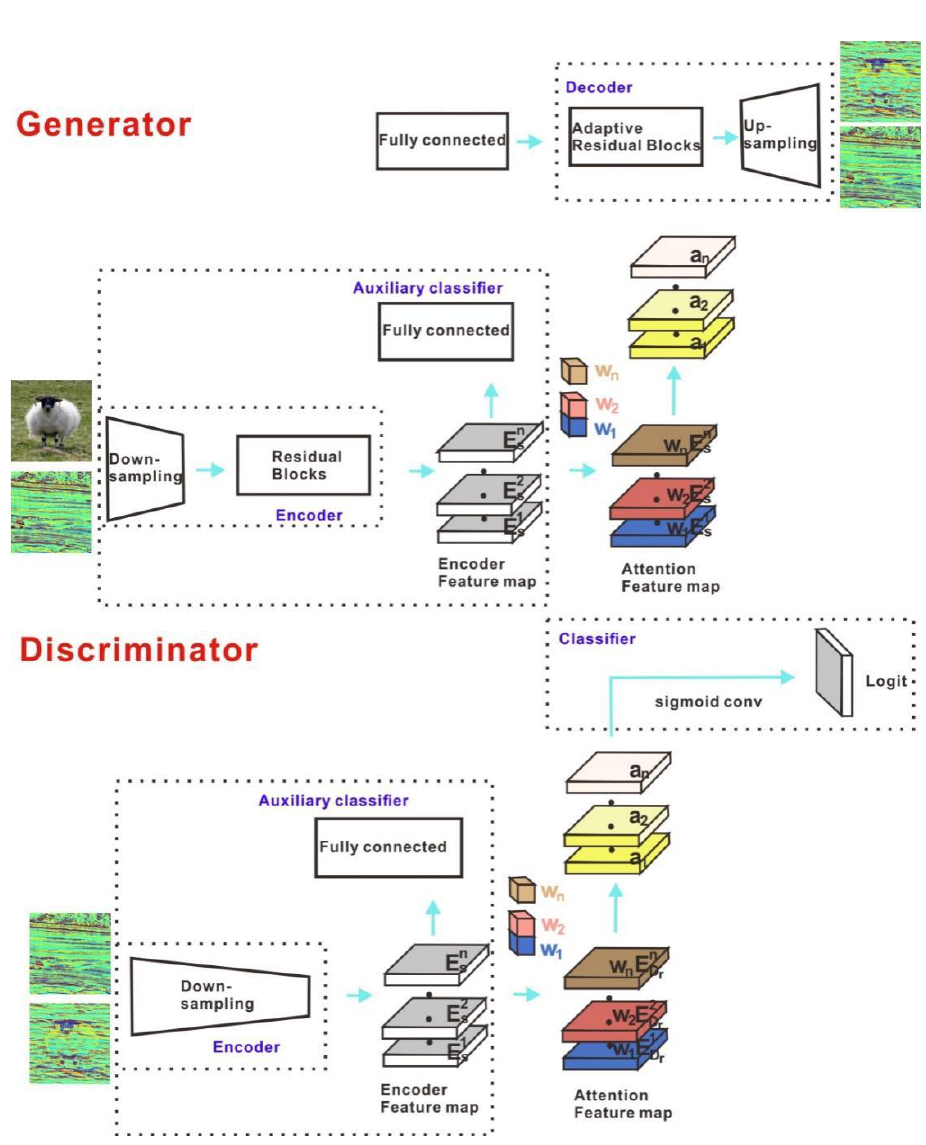
Figure 2. Network structure of normalized unsupervised generation of adaptive layer instances [28]. The generator has a decoder module implemented by the AdaLIN algorithm more than in the discriminator. The input image of the generator creates the feature map through the encoding stage E s of the Encoder, and then an auxiliary classifier η s is added. The attention mechanism is introduced to maximize the pooling of the feature map. The prediction of a node is output through the full connection layer, and then the parameters of the full connection layer and the feature map are multiplied to obtain the feature map of attention. Finally, the output image is obtained through Decoder module G t . The discriminator compresses the input image at a deeper level and adds an auxiliary classifier η D . Finally, the output is judged by the classifier C D . The model’s objectives include four loss functions, including antagonistic loss, which are used to match the generated and target image distributions: